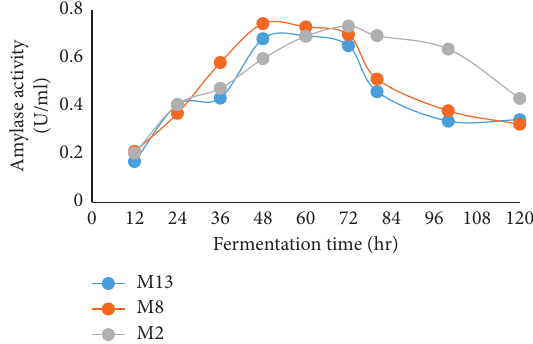
Figure 8: Effects of the time course on amylase production from selected bacterial isolates.